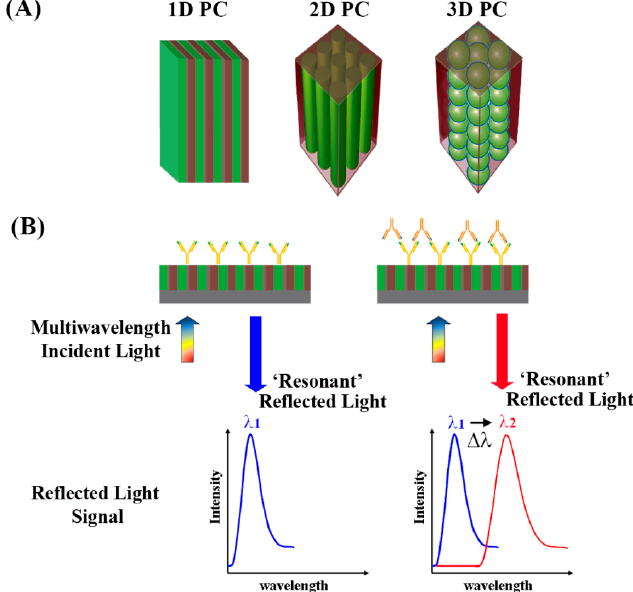
Figure 18. ( A ) 1D, 2D, and 3D PC systems are shown with the different colors corresponding to materials of different refractive indices; ( B ) Upon analyte binding, the resonant wavelength of the reflected light changes its wavelength from the original value by Δ λ